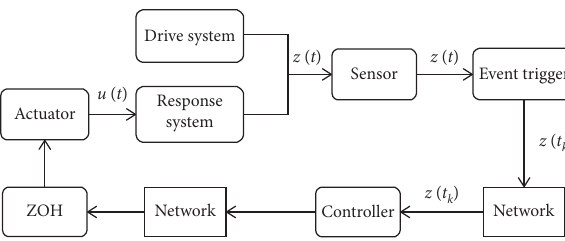
Figure 1: Schematic of event-triggered control strategy.